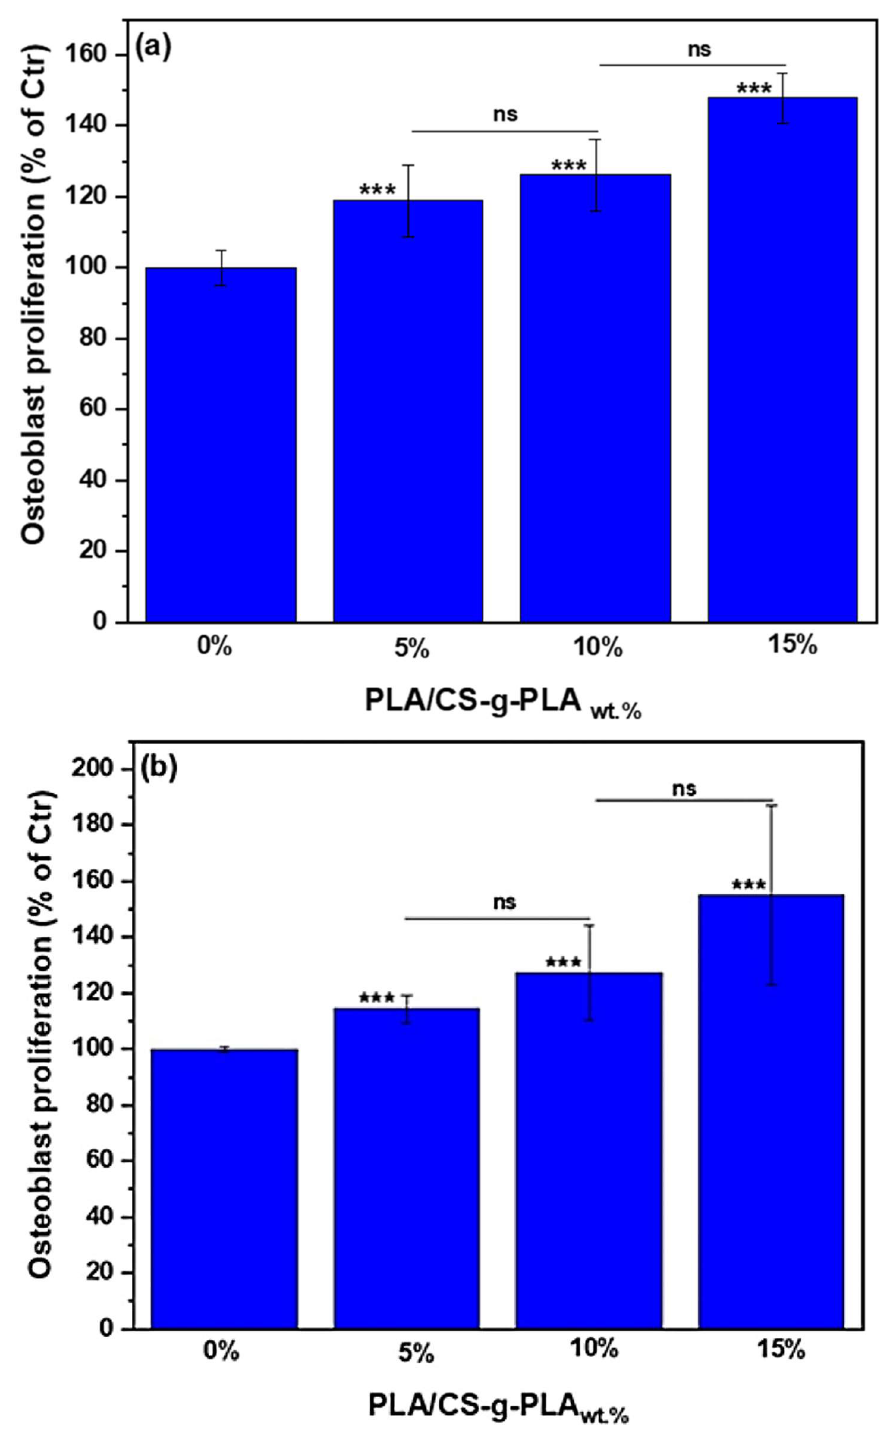
Figure 11. Osteoblast cells proliferation after 3 days ( a ) and 5 days ( b ) for pure PLA (Control, Ctr) and PLA/CS-g-PLA porous scaffolds at different CS-g-PLA contents. (*** p ˂ 0.001; ns = not significant).